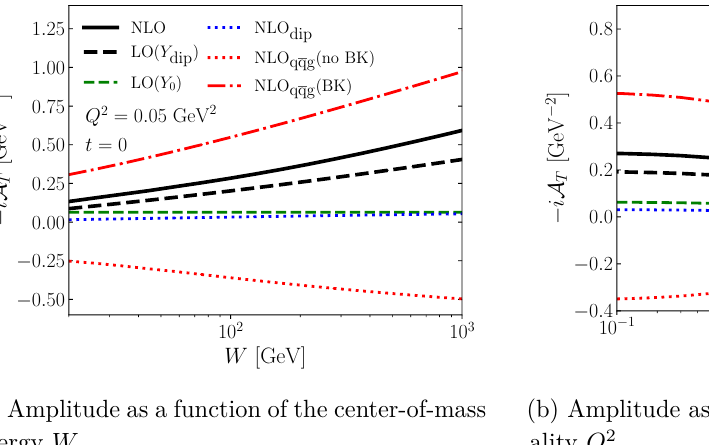
(a) Amplitude as a function of the center-of-mass energy W . Figure 2. Different contributions to the transverse exclusive J /ψ production scattering amplitude at next-to-leading